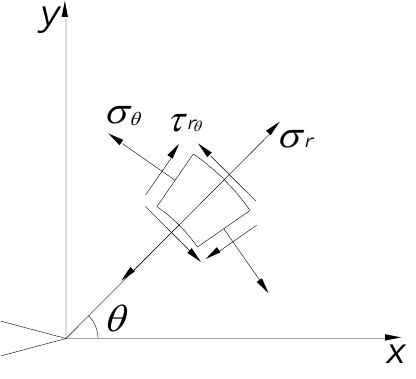
Figure 3. Stress state of the unit at the interfacial crack tip.